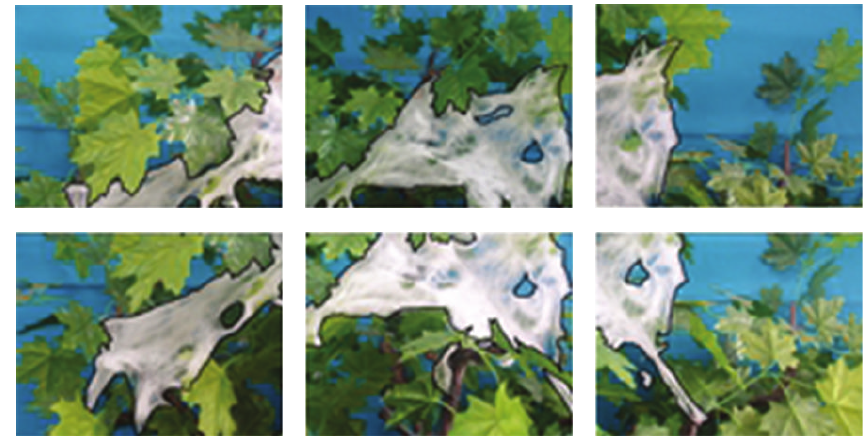
Figure 10: Real-time processing results.